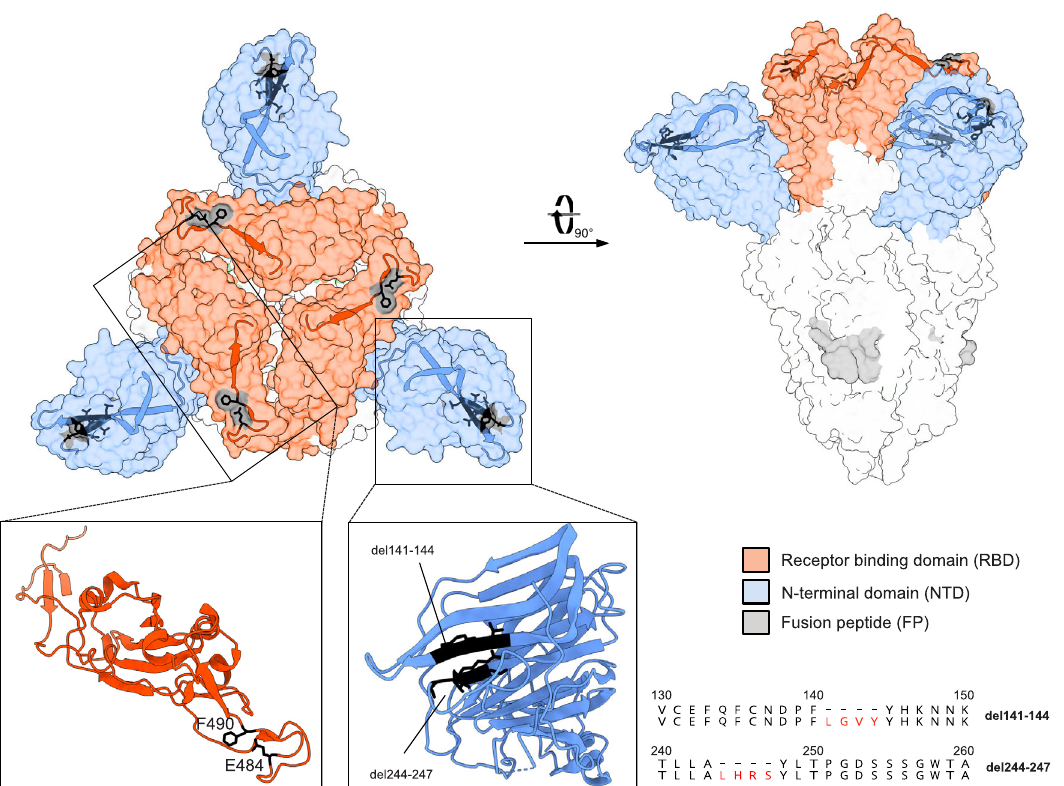
Fig. 3 Structure of the SARS-CoV-2 spike trimer. The spike structure (PDB accession number: 7BNM) with the most prominent mutations in the patient viral sequences is shown in the surface presentation. The NTD is colored in blue and the RBD in red. Close-ups of the single NTD and RBD regions de fi ned by boxes are presented as ribbons. The location of the deletions in the NTD and amino acid substitutions in the RBD are indicated by black residues. Furthermore, the deletions in the NTD are displayed as amino acid alignments at the